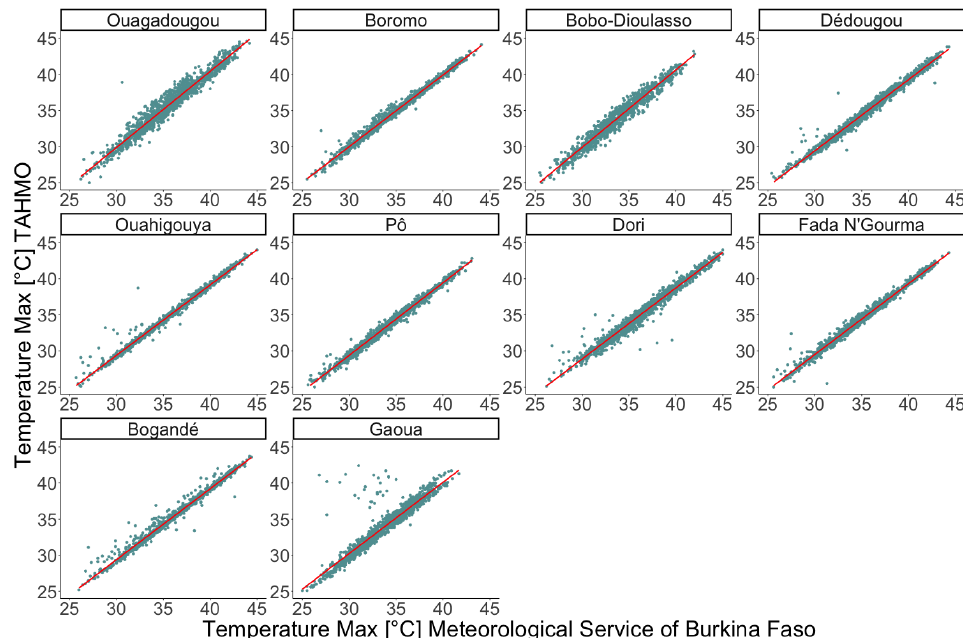
Figure 9. Scatterplot between maximum temperature time series of TAHMO stations ( y -axis) and the corresponding stations from meteorological service of Burkina Faso ( x